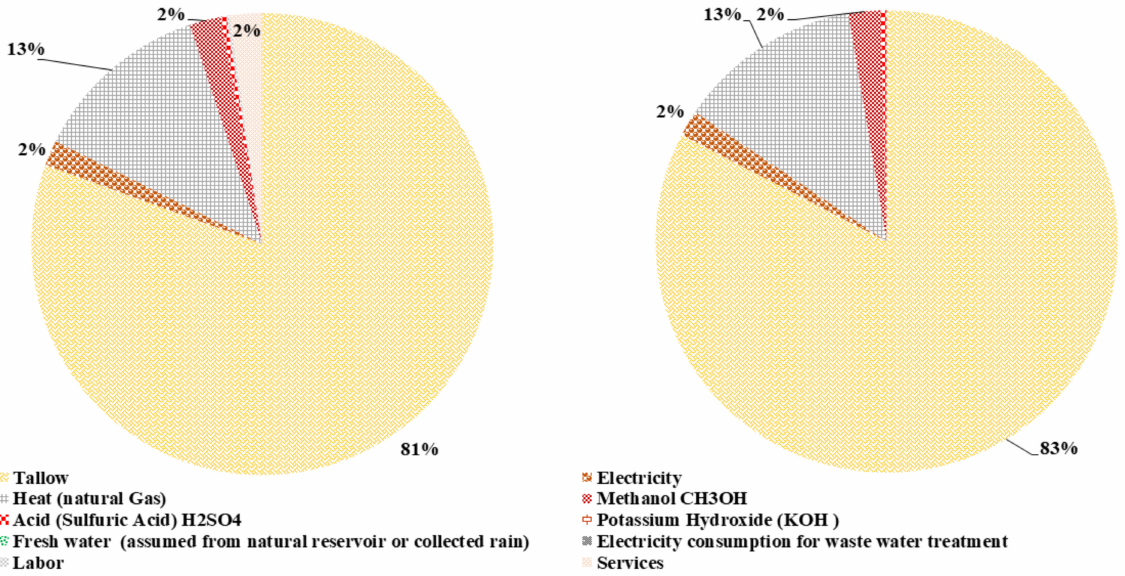
Figure 4. Contribution of different input flows for the emergy content of biodiesel production with and without